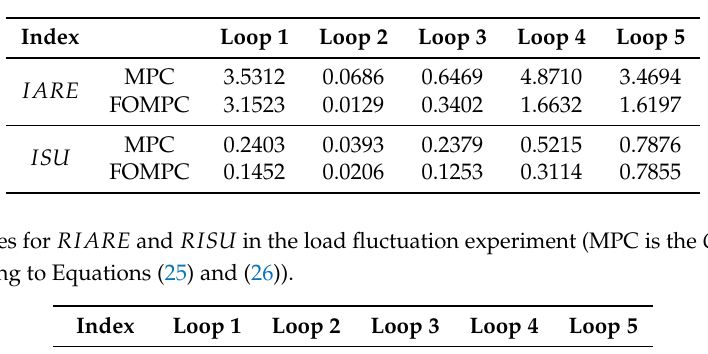
Table 7. Indexes for IARE and ISU in the load fluctuation